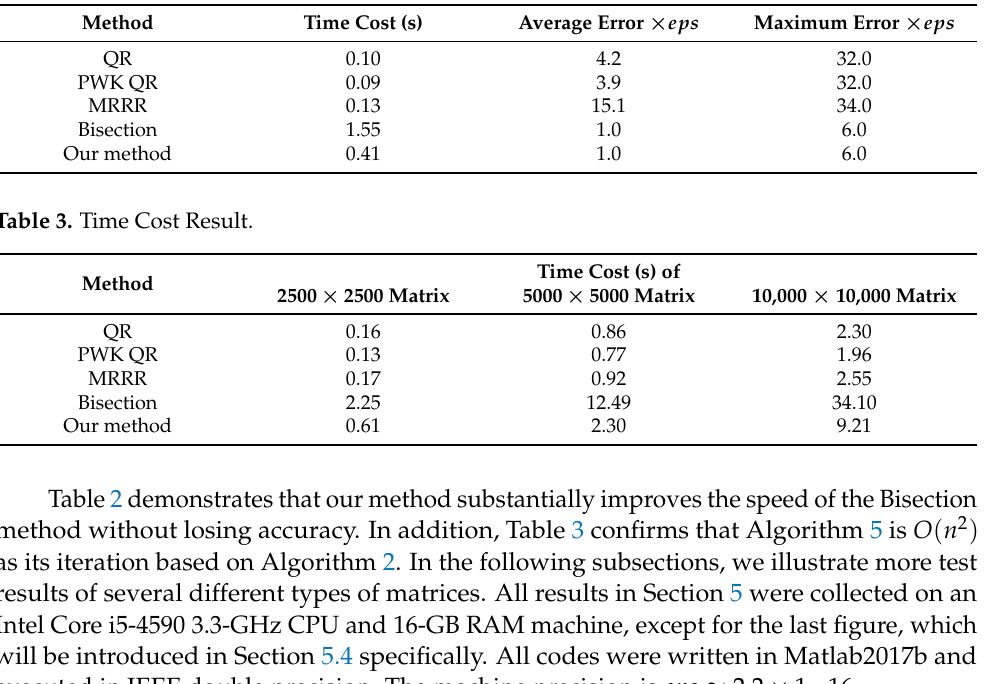
Table 2. Accuracy Result.